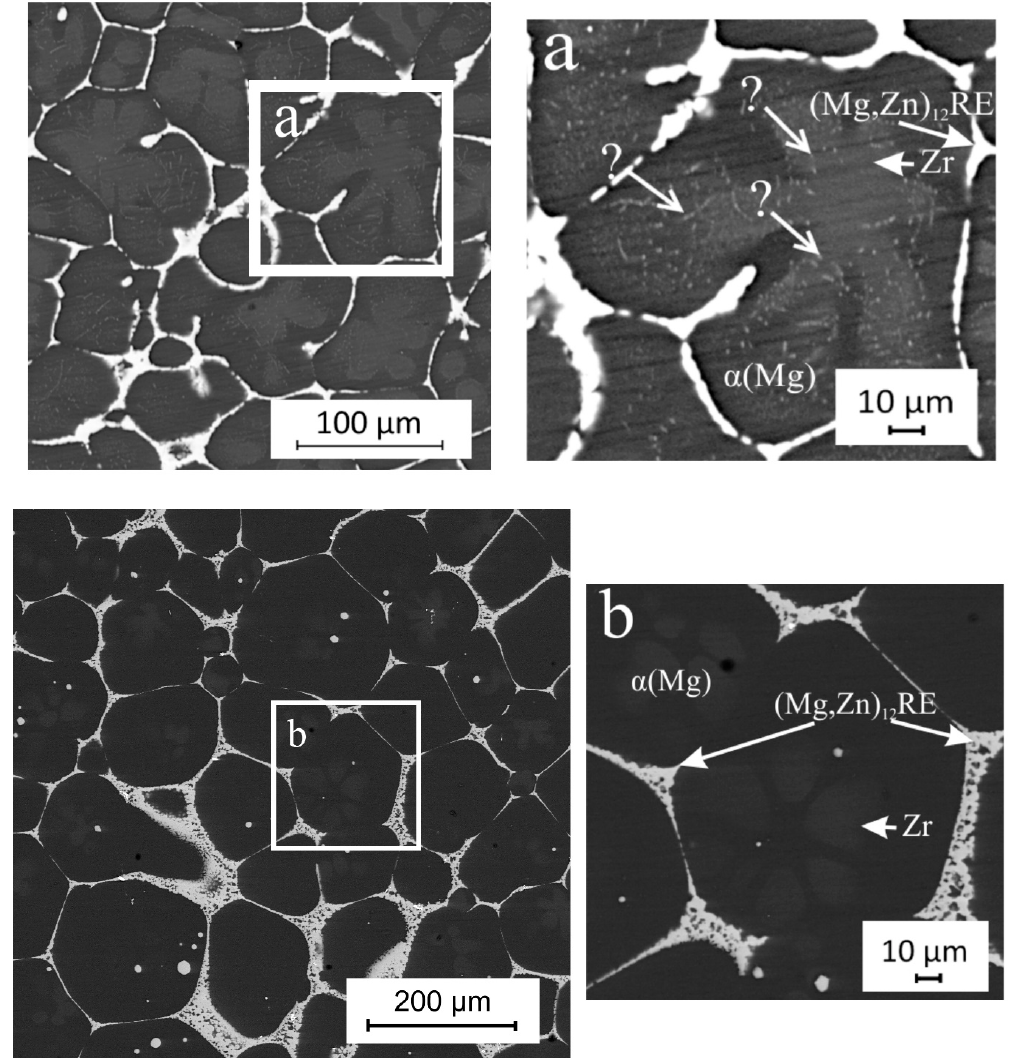
Figure 1. Scanning electron microscope (SEM) micrographs of Mg-cast alloy EZ33A. ( a ) As-cast structure of ingot. White question marks indicate presence of nanoparticles in grain interiors. ( b ) Microstructure after annealing at 550 °C for 2 h [4].